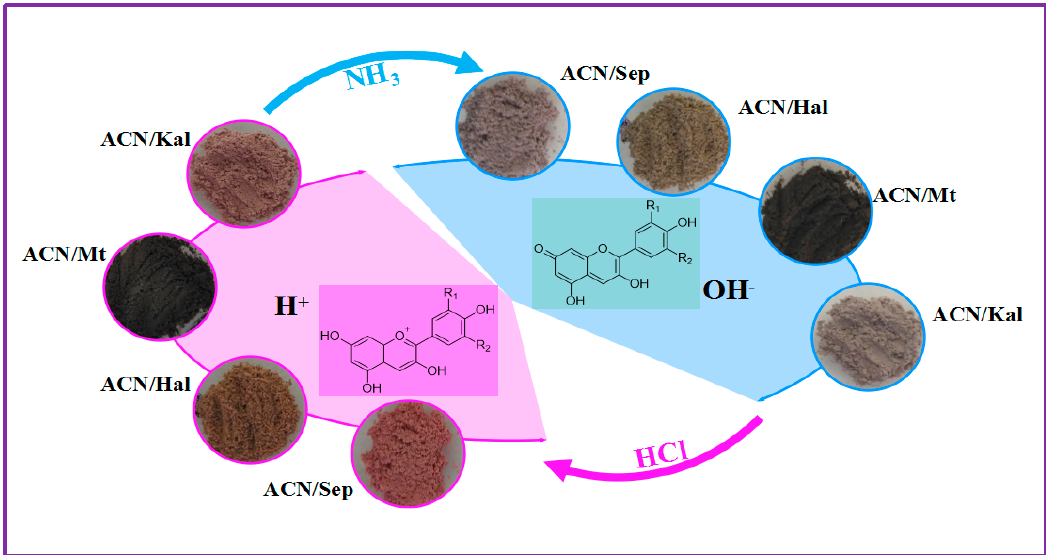
Figure 8. Images and scheme of the color change of ACN / Kal, ACN / Mt, ACN / Hal, and ACN / Sep in acidic and alkaline atmospheres in sequence (R1, R2 = H, OH, OCH 3 ).